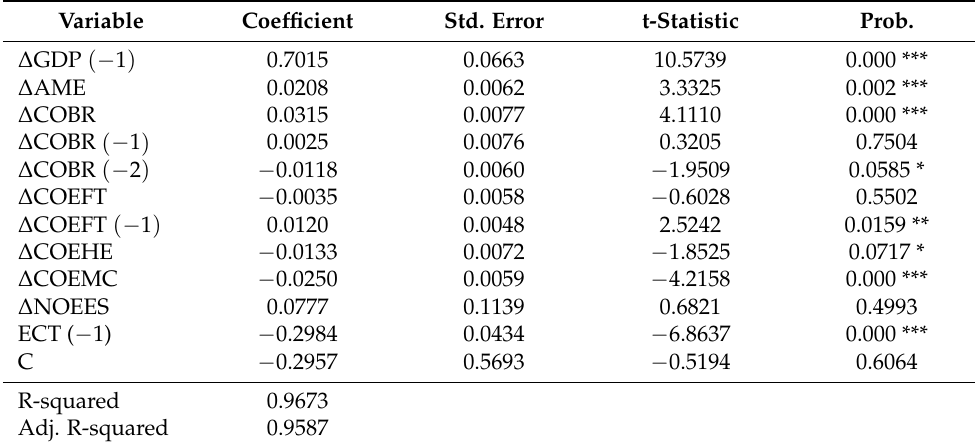
Table 5. ARDL short-run relationships.